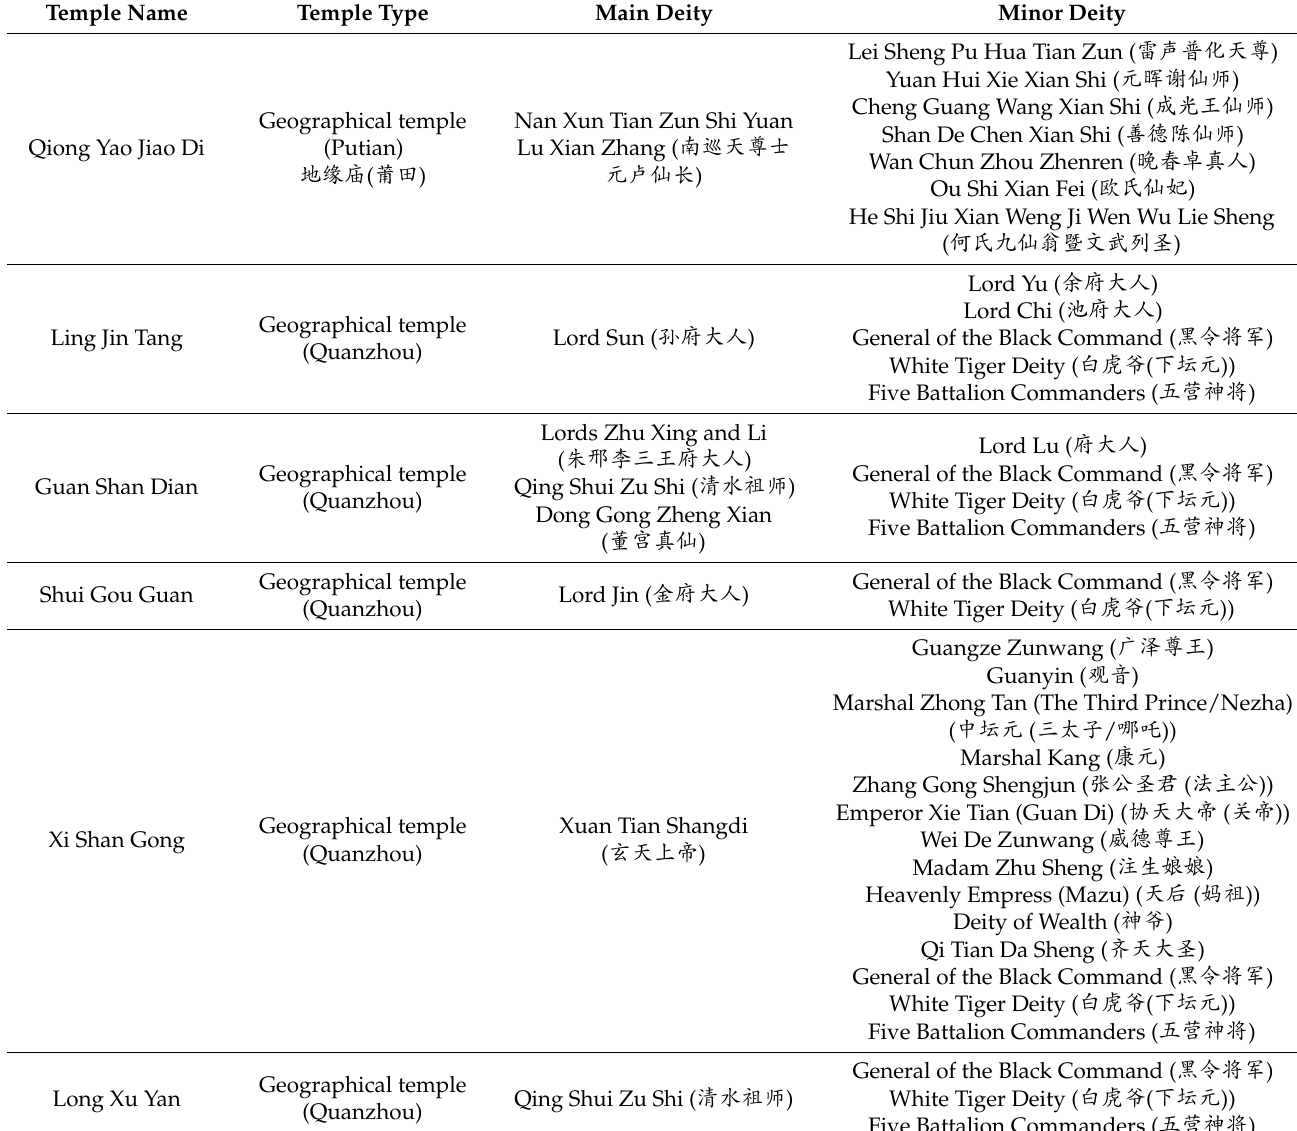
Table 7. Deities enshrined in the Jurong Combined Temple( 裕 廊 总 宫